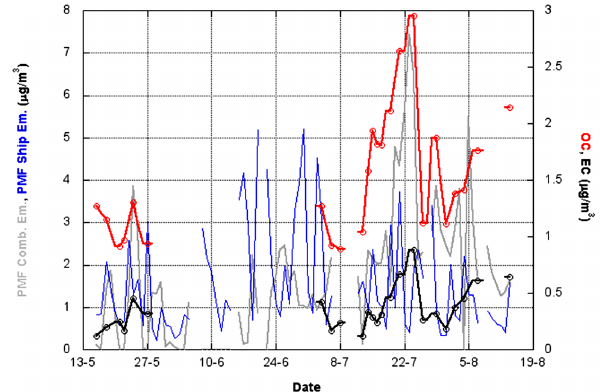
Figure 7. Comparison between EC and OC data and PMF estimates of the contributions of combustion emissions and primary particu- late ship emissions in the period of EC/OC data availability. Re- sults for EC and OC are reported with solid lines (black and red, respectively), referring to the secondary axis (empty rounds report the single sample result attributing it to the central sampling